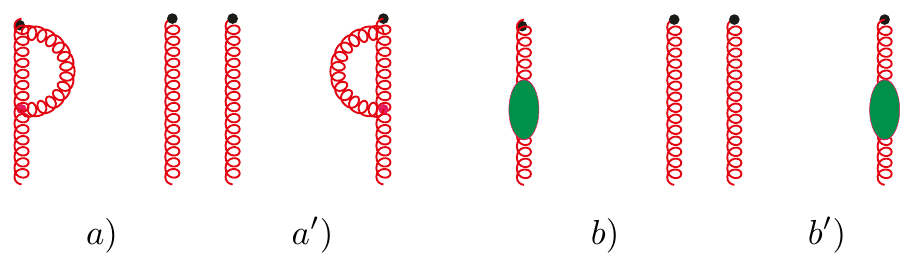
Figure 2 . Self-energy-type